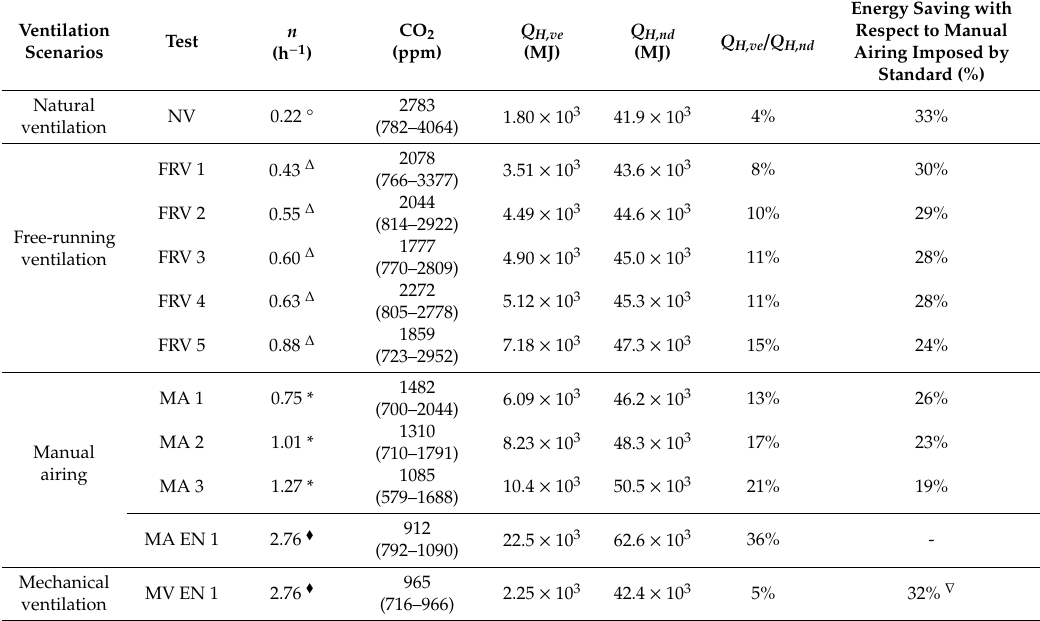
Table 3. Median values of air exchange rates ( n ), CO 2 concentrations and energy needs ( Q H,ve , Q H,nd ) measured / estimated for the test-classroom under di ff erent ventilation scenarios.